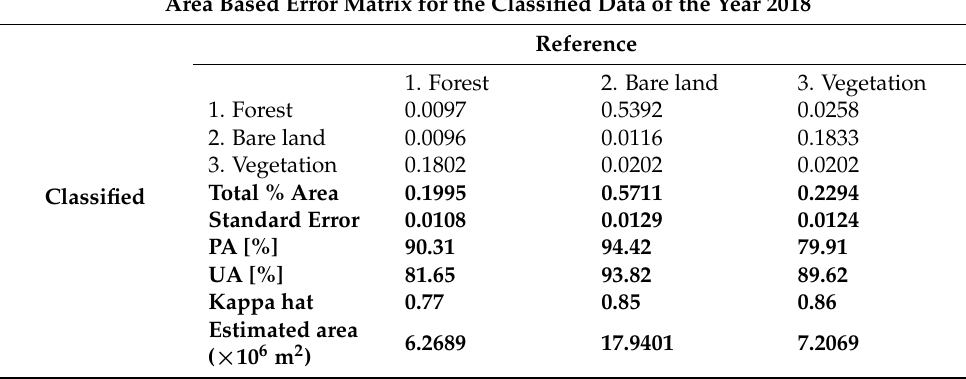
Table 12. Accuracy assessment parameters for the classified data of the year 2018.